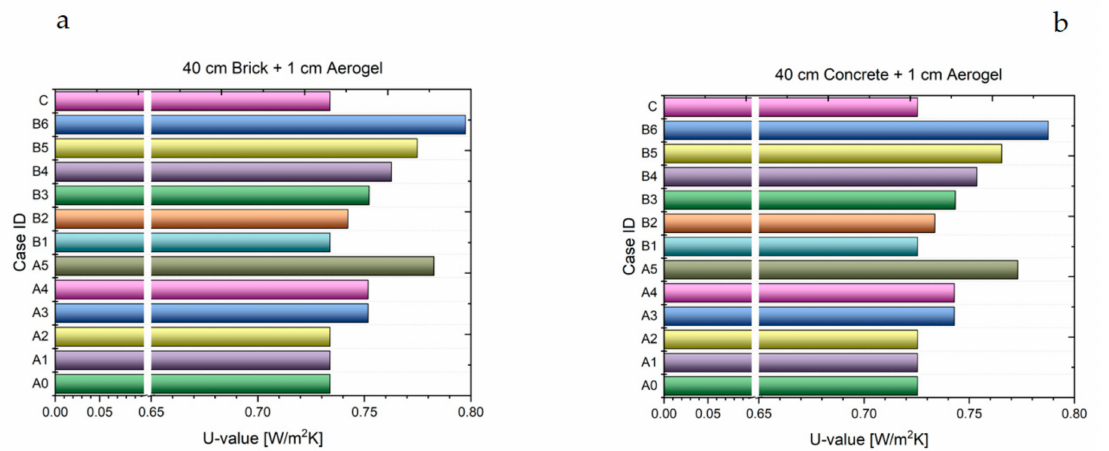
Figure 4. The hypothetical structures of ( a ) brick with 1 cm of aerogel and ( b ) concrete with 1 cm of